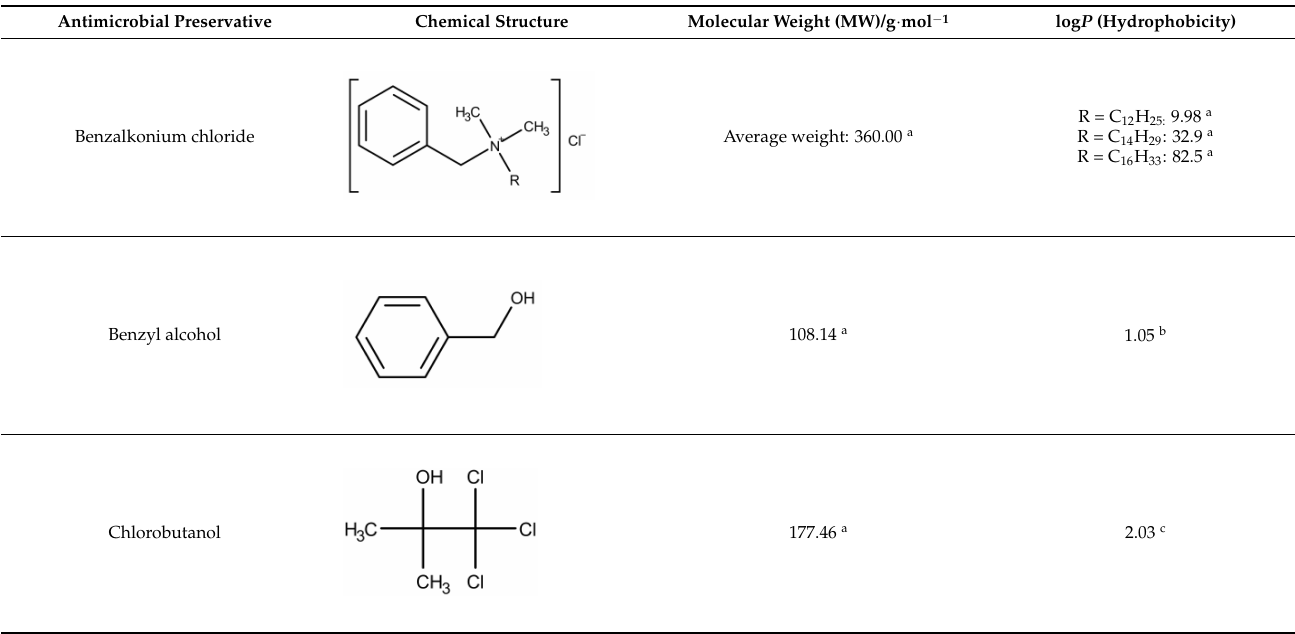
Table 1. Structural formulae, molecular weight [g · mol − 1 ], and log P values of commonly used antimicrobial preservatives. Abbreviations: R = mixtures of